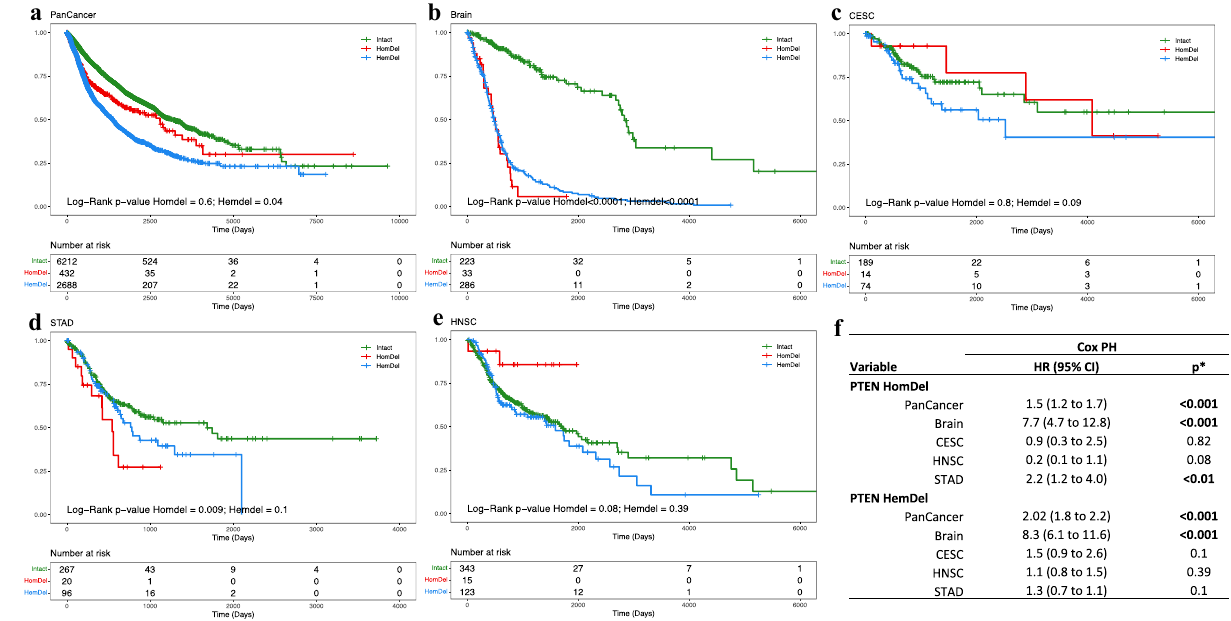
Figure 3. Kaplan–Meier curves illustrate overall survival for both PTEN intact and PTEN deletions groups (HemDel and HomDel). Boxplots ( a ) Pan-cancer cohort shows a lower survival probability for PTEN HemDel compared to HomDel and intact (P < 0.0001). ( b ) Brain tumors (GBM + LGG) show that both HomDel and HemDel are equally associated with earlier events (P < 0.0001). ( c ) Cervical tumors show a lower survival probability for PTEN HemDel compared to HomDel and intact. ( d ) Head and neck cancer. ( e ) Stomach tumors. ( f ) Cox Model analysis for PTEN intact and PTEN deletions groups. Plotted using Survminer (https:// rpkgs. datan ovia. com/ survm iner/ index.